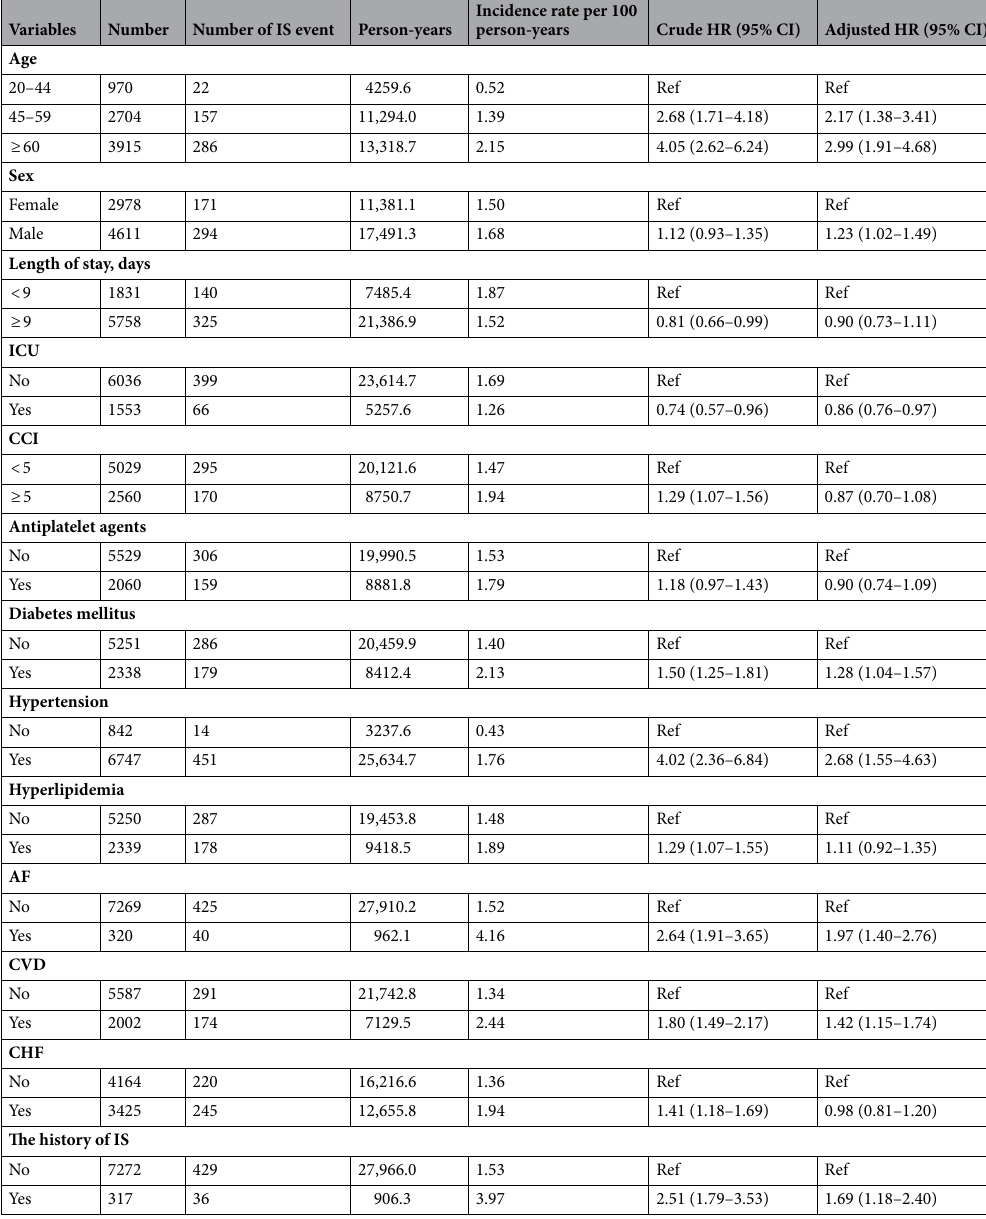
Table 2. The relationship between antiplatelet agent use and 5-year rate of ischemic stroke recurrence among patients with first-time hemorrhage stroke (n = 7589). ICU, intensive care unit; CI, confidence interval; AF, atrial fibrillation; CHF, congestive heart failure; IS, ischemic stroke; HR, hazard ratio; CVD, cardiovascular